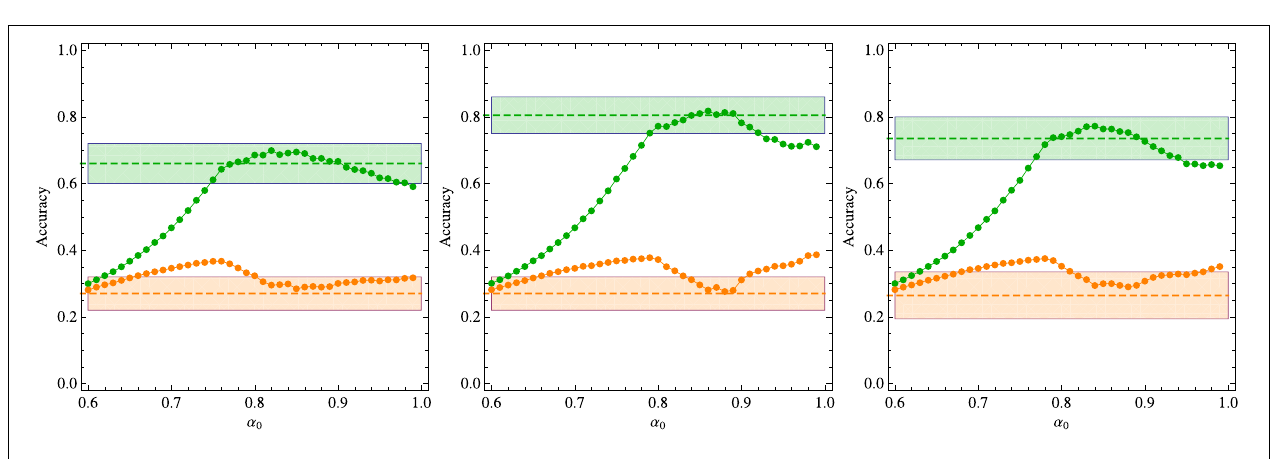
FIGURE 6 | Results of the experiments on mutual exclusivity in the case the late phase of the training process comprises 6 repetitions of each word. The green symbols represent the probability that the algorithm picks object o 7 as the referent of word w 7 whereas the orange symbols represent the probability it picks o 1 . The broken horizontal lines and the shaded zones around them represent the experimental means and standard deviations